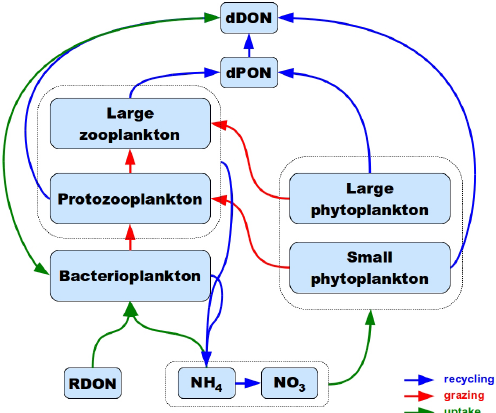
Figure 1. Conceptual diagram of the biogeochemical model. The 10 state variables are nitrate (NO 3 ) , ammonium (NH 4 ) , large (>5µm) and small (<5µm) phytoplankton, large zooplankton, protozoo- plankton, bacterioplankton, detrital particulate and dissolved or- ganic nitrogen (dPON and dDON, respectively), and usable river- ine dissolved organic nitrogen (RDON). Green, red and blue arrows represent nutrient uptake, grazing, and nitrogen recycling, respec-